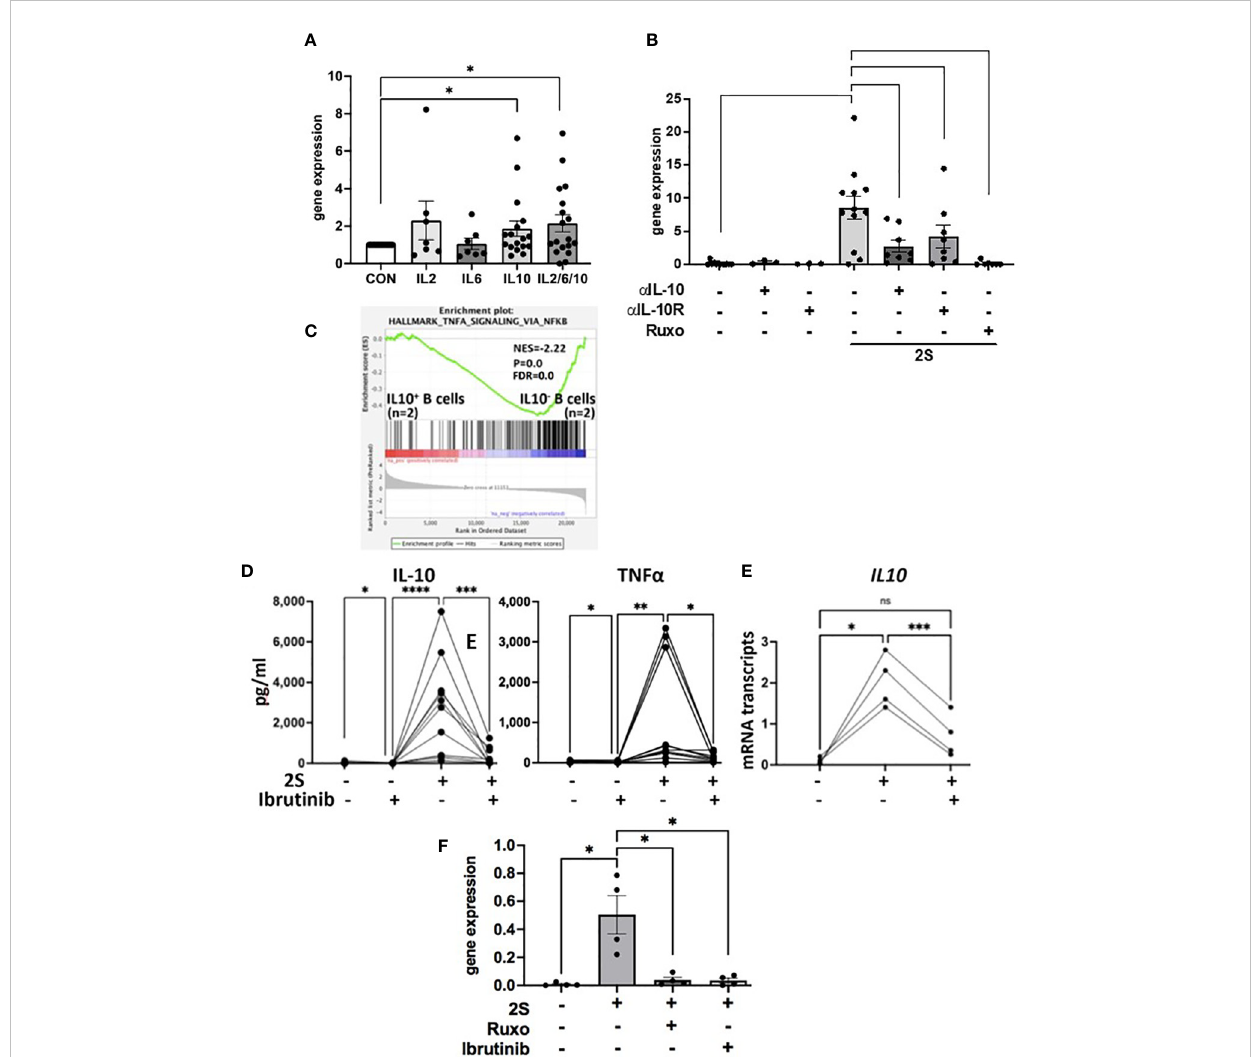
FIGURE 5 Regulation of IL10 transcription and TLR-activation in the presence of ibrutinib. CLL cells were cultured alone, with IL-2, IL-6, IL-10, or combinations of IL-2, -6, and -10 (A) or with IL-2 and resiquimod (2S) in the presence and absence of IL-10 or IL-10 receptor blocking antibodies (B) , ruxolitinib (B, F) , or ibrutinib (300 nM). (A, B, E, F) IL10 transcripts were measured after 4 (E) and 24 h (A, B, F) . (D) IL-10 (left panel) and TNF a (right panel) in culture supernatants were measured after 48 h. Averages and standard errors are shown in the boxes and the lines and closed circles represent results for individual samples. (C) Microarray data from 2 samples each of IL-10-secreting and -nonsecreting CD69 + human B cells indicated by an IL-10 capture assay after 2 days of stimulation with CpG oligonucleotides, IL-4, and CD40 antibodies were down-loaded from data-set GSE49853. DEGs were obtained with GEO2R software, ranked in order of decreasing logFc values, and analyzed by GSEA against the Hallmarks gene set collection in MsigDB. The plot depicts signi fi cant enrichment of NF k B-signaling genes in TLR-activated human B cells in the absence of autocrine IL10. *, p<.05;**, p<.01; ***, p<.001; ****, p<.0001; ns=not signi fi cant. Statistical analysis was done by students paired t tests and 2-way